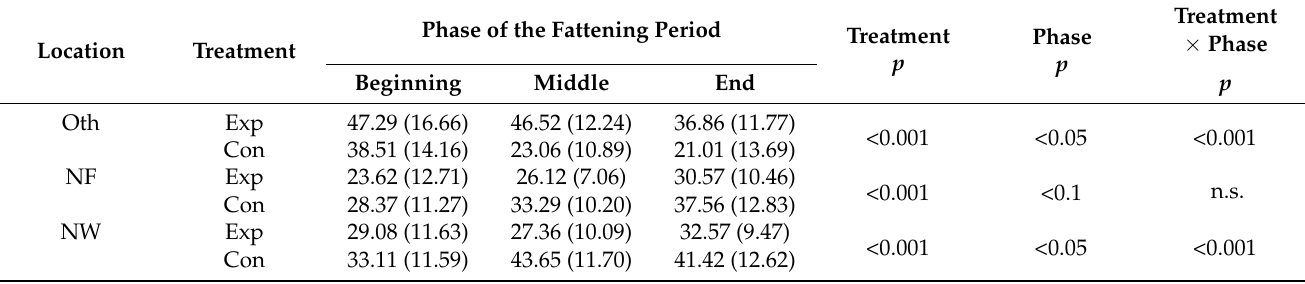
Table 3. Mean proportion (%) of animals categorized as located at ‘other’ (Oth), ‘located near the feeding trough’ (NF), and ‘located near the water line’ (NW) at the different phases of the fattening period on the perforated floor (Exp) and in the control area (Con) ( n = three trials each). Standard deviations are presented in parentheses, n.s. = result is not significant at p < 0.05.